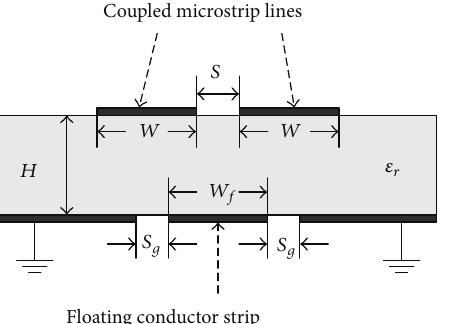
Figure 1: Cross-sectional view of parallel coupled microstrip lines with a floating ground-plane conductor.